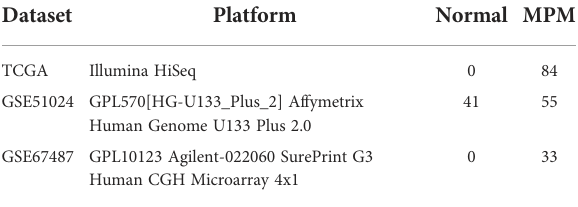
TABLE 1 Basic characteristics of the gene expression pro fi le data.